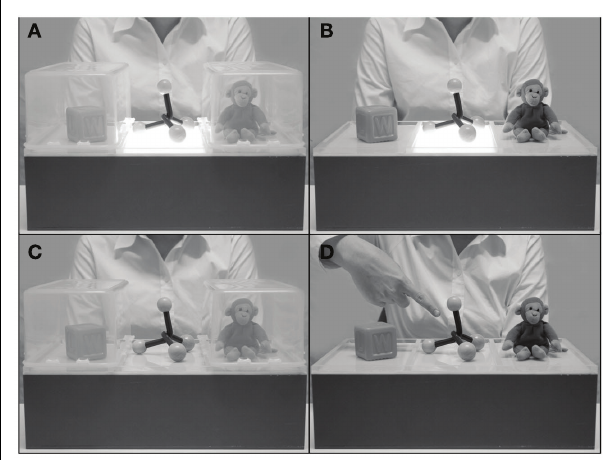
FIGURE 1 |An example of feedback on a fode trial for each condition. (A) Highlight-target/dampen-competitors, (B) highlight-target, (C) dampen-competitors, (D) control